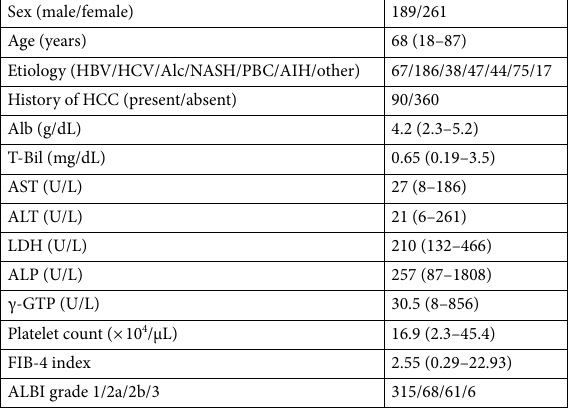
Table 1. Patient background and laboratory data at the evaluation of pruritus in 450 patients with chronic liver disease. Laboratory data are expressed as median (range) values. AIH autoimmune hepatitis, HBV